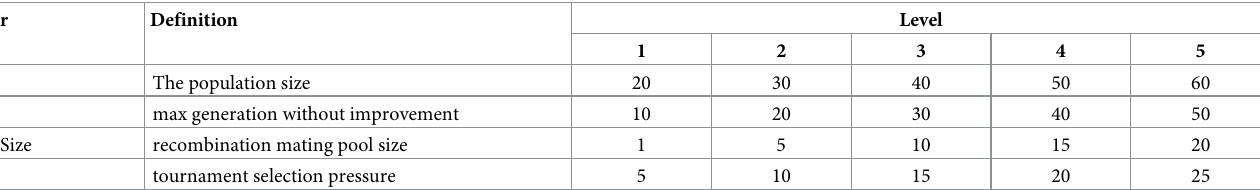
Table 2. The AMADE algorithm parameter levels.